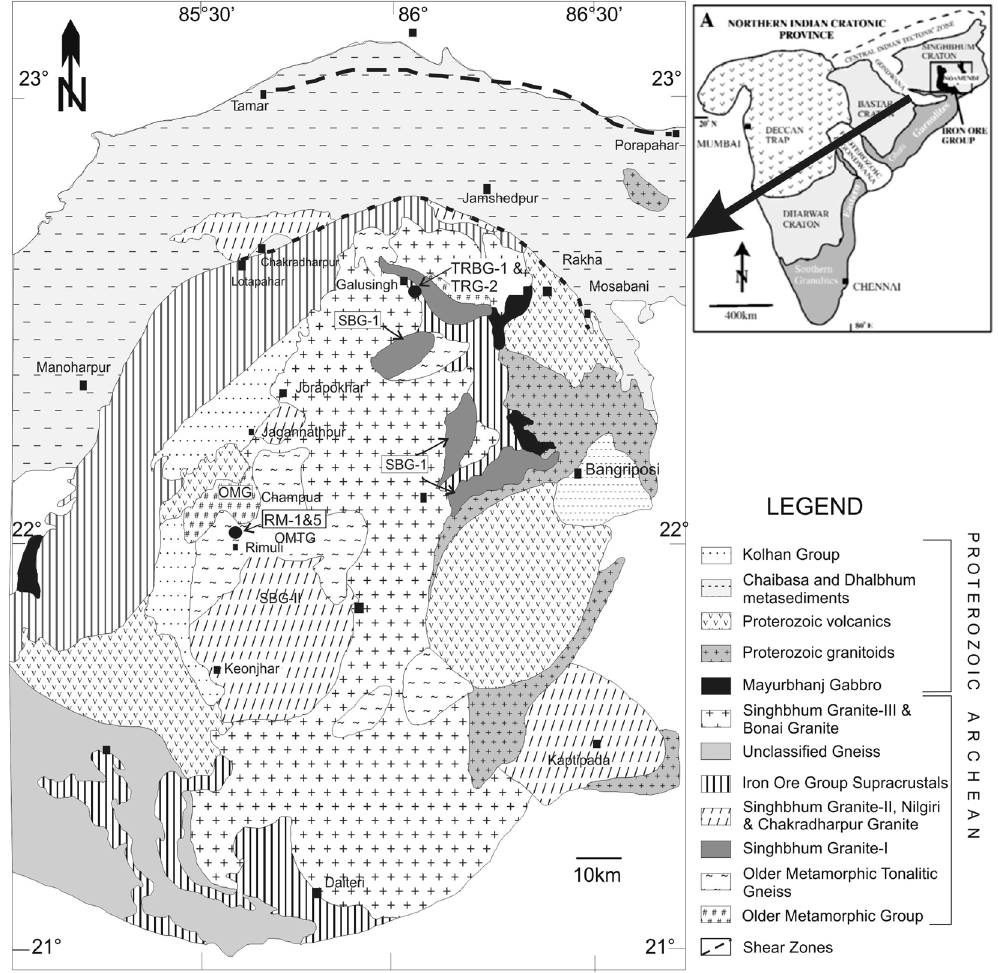
Figure 1. Geological map of the Singhbhum Craton (modified after Upadhyay et al . 37 ) showing sample locations of the dated TTGs. The map was modified using software Corel Draw ® Graphics Suite